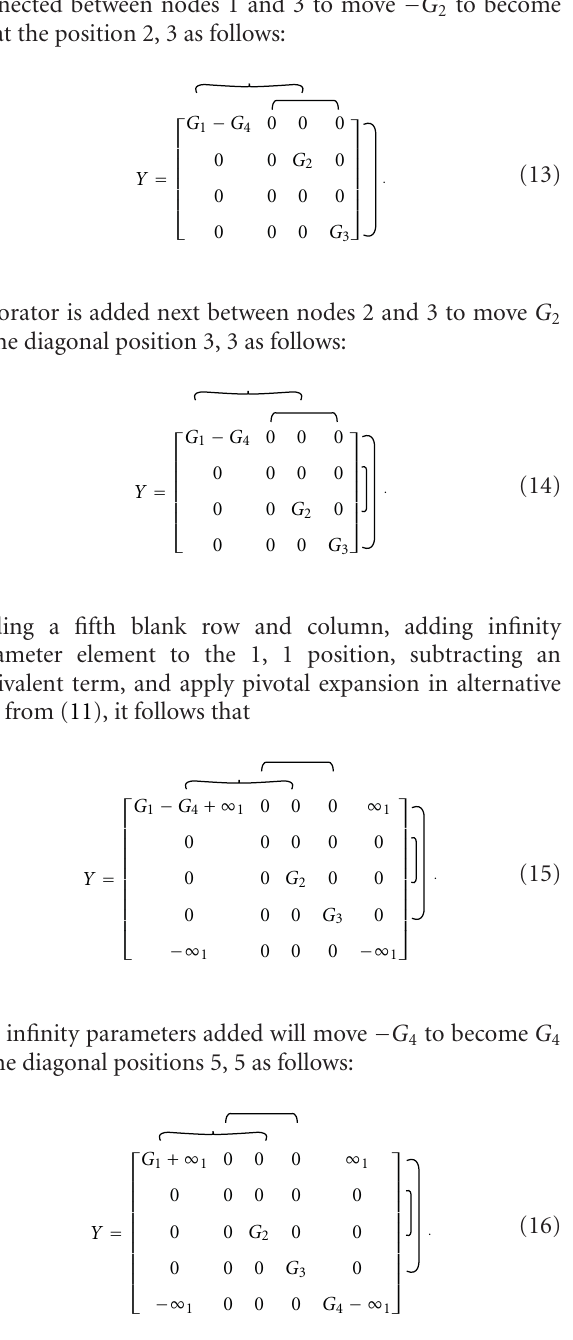
Figure 3(a) represents the pathological element realization of the above equation after connecting the two capacitors at nodes 1 and